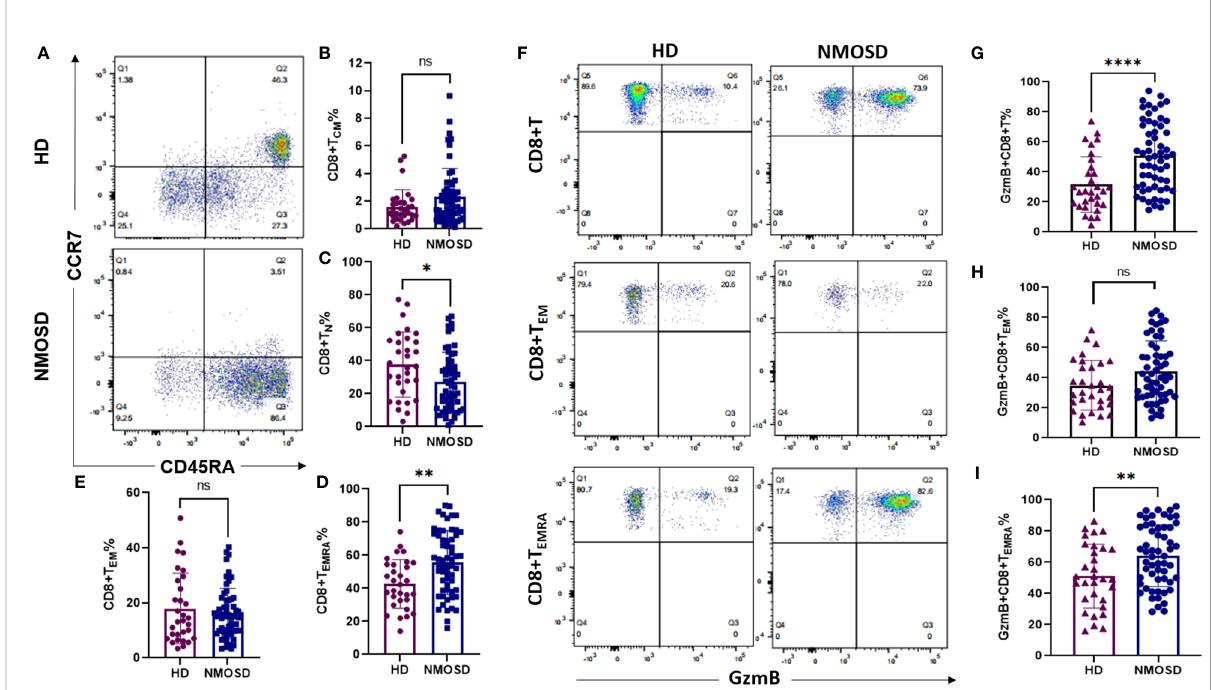
FIGURE 1 Circulating CD8+ T cell subpopulations and GzmB expression in patients with NMOSD and HD. Peripheral blood was collected from healthy donors (HD) (n=31) and patients with neuromyelitis optica spectrum disorder (NMOSD) (n=59). (A) The fl ow cytometric gating strategy for CD8+ T cell subpopulations. Central memory (T CM , CCD7+CD45RA-), naïve (T N , CCD7+CD45RA+), effector memory (T EM , CCD7-CD45RA-), and terminal differentiation effector memory T cells (T EMRA , CCD7-CD45RA+). (B – E) Comparison of CD8+ T cell subsets between HD and